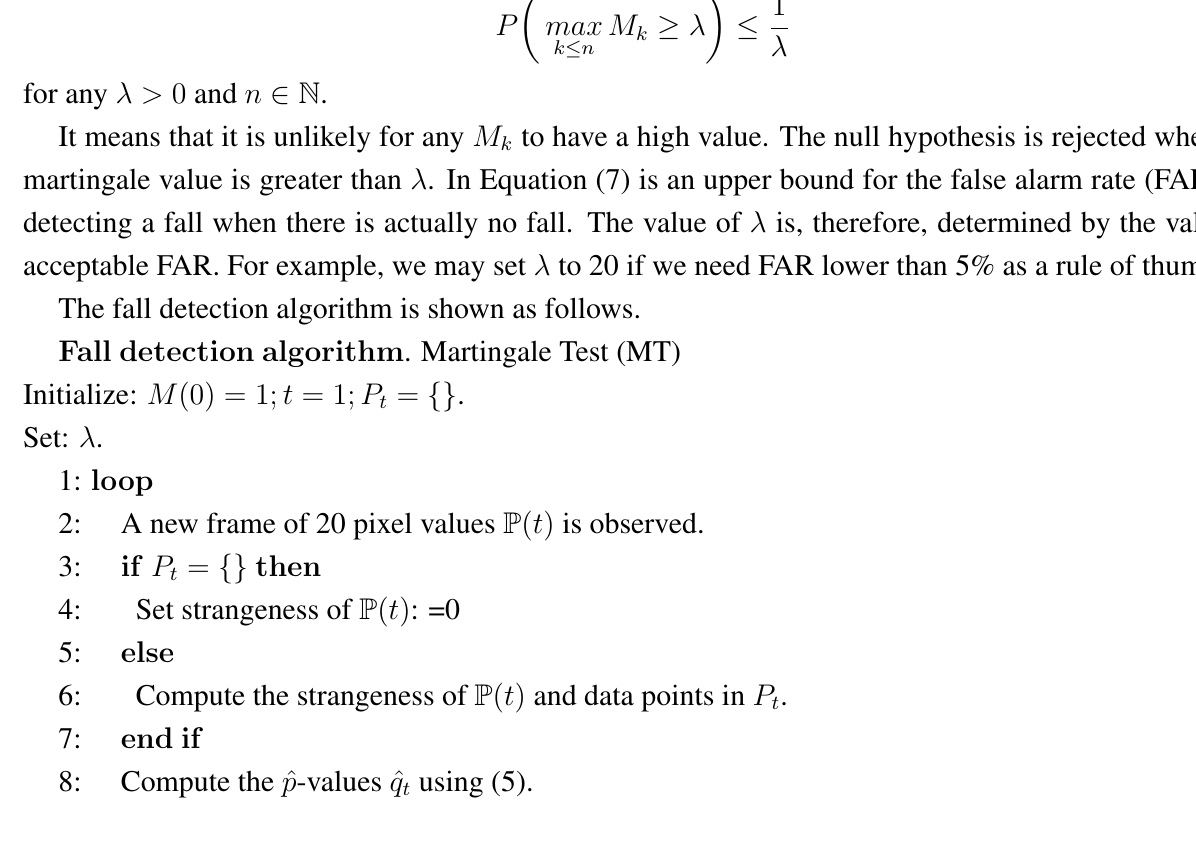
Fall detection algorithm . Martingale Test